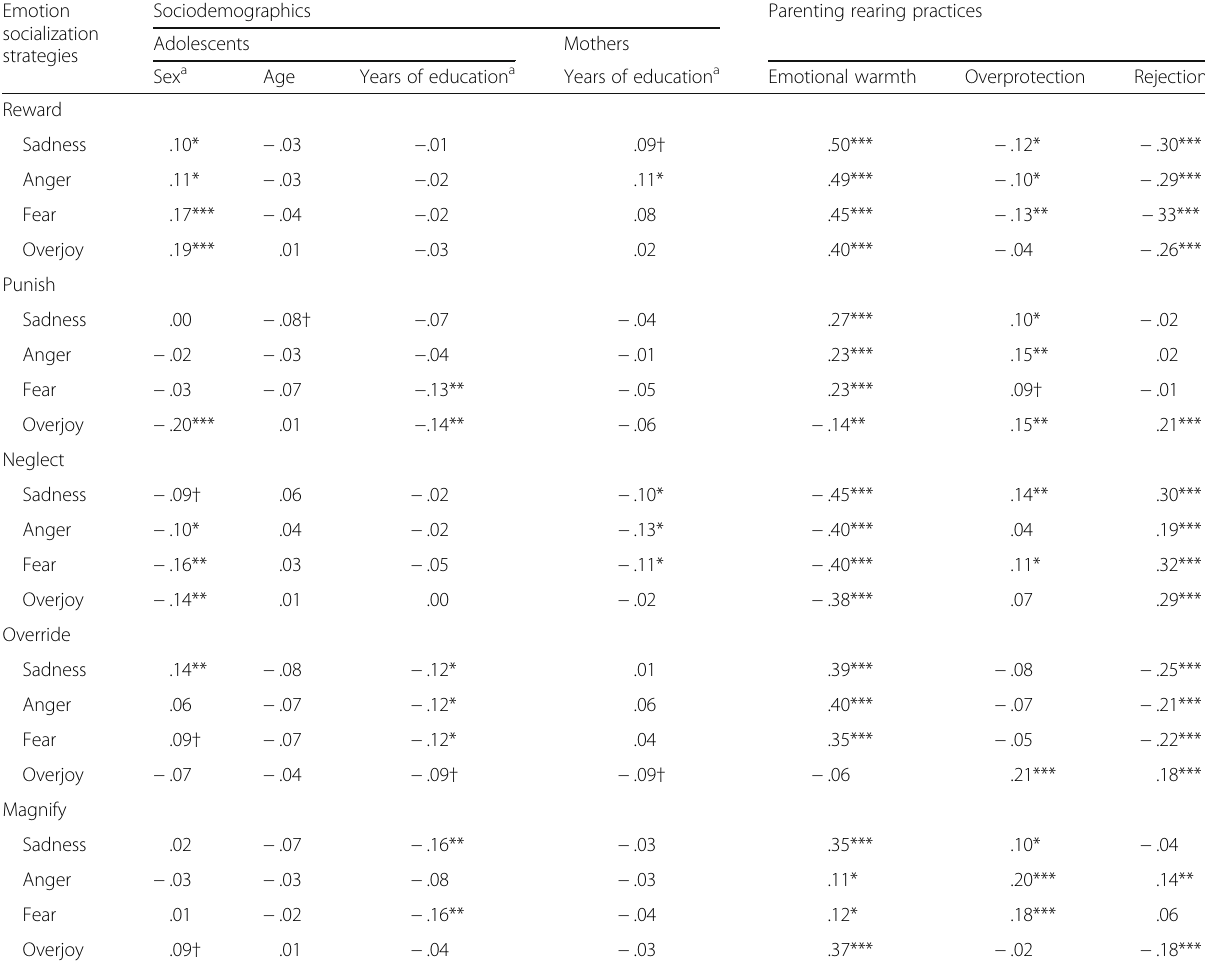
Table 4 Correlations between emotion socialization strategies and sociodemographics and parenting practices ( N = 418) Emotion socialization